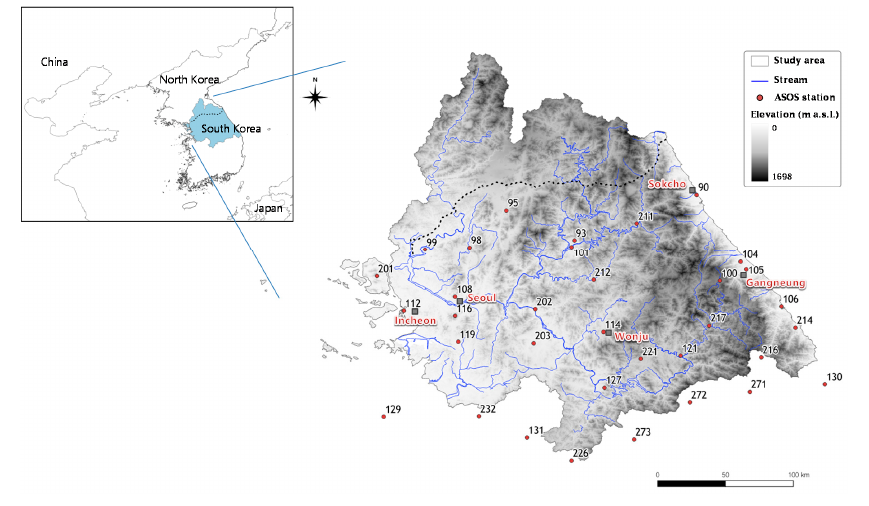
Figure 1. Study area. Table 1. ASOS stations used in this